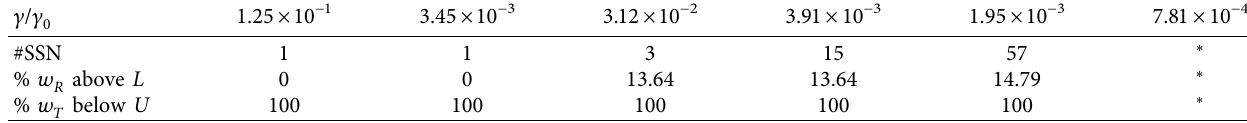
Table 1: Results for dose-constrained equation (2): number of SSN steps, volume fraction for risk, and target regions for diferent values of c . c / c 0